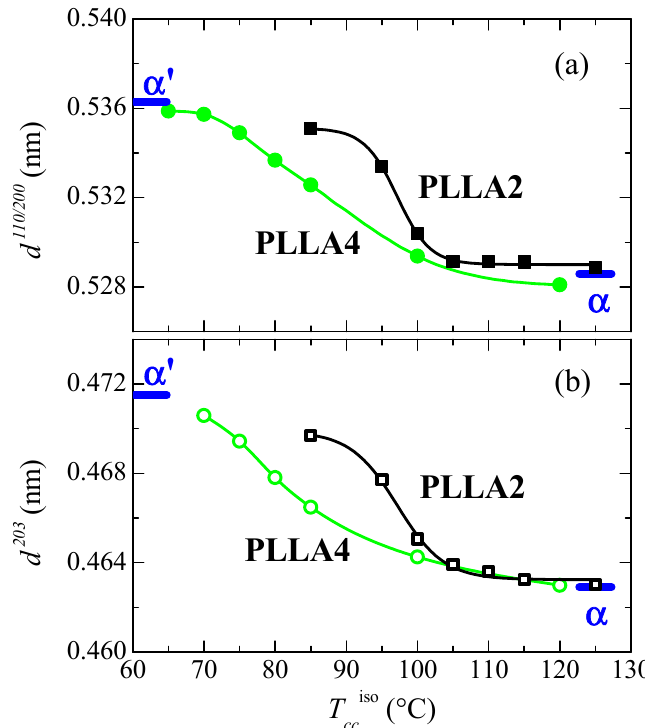
Figure 10. Variation with T cc iso of the PLLA2 and PLLA4 spacings, at room temperature, for ( a ) the (110/200) diffraction; ( b ) the (203) diffraction (see Figure 8a,b). The thick marks are the corresponding values described in ref. [32] for the α ’ and α modifications.